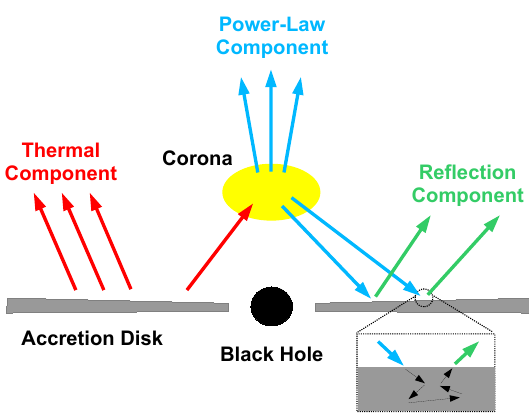
Figure 1. A black hole is accreting from a geometrically thin and optically thick disk. The disk has a multi-temperature blackbody spectrum (red arrows). Thermal photons from the disk can inverse Compton scatter off free electrons in the corona, producing a power-law component (blue arrows). Comptonized photons can illuminate the disk, generating a reflection component (green